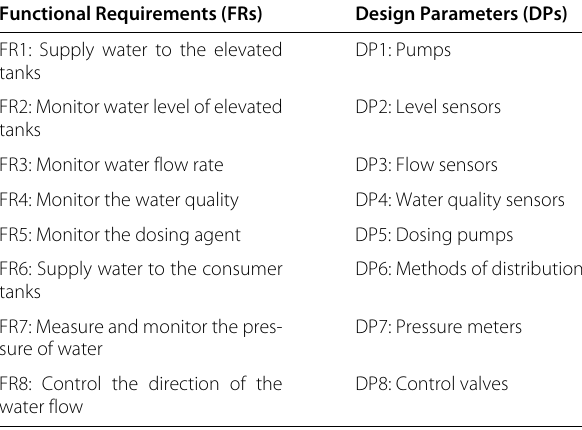
Table 5 Top-level decomposition of WADI Functional Requirements (FRs) Design Parameters (DPs)